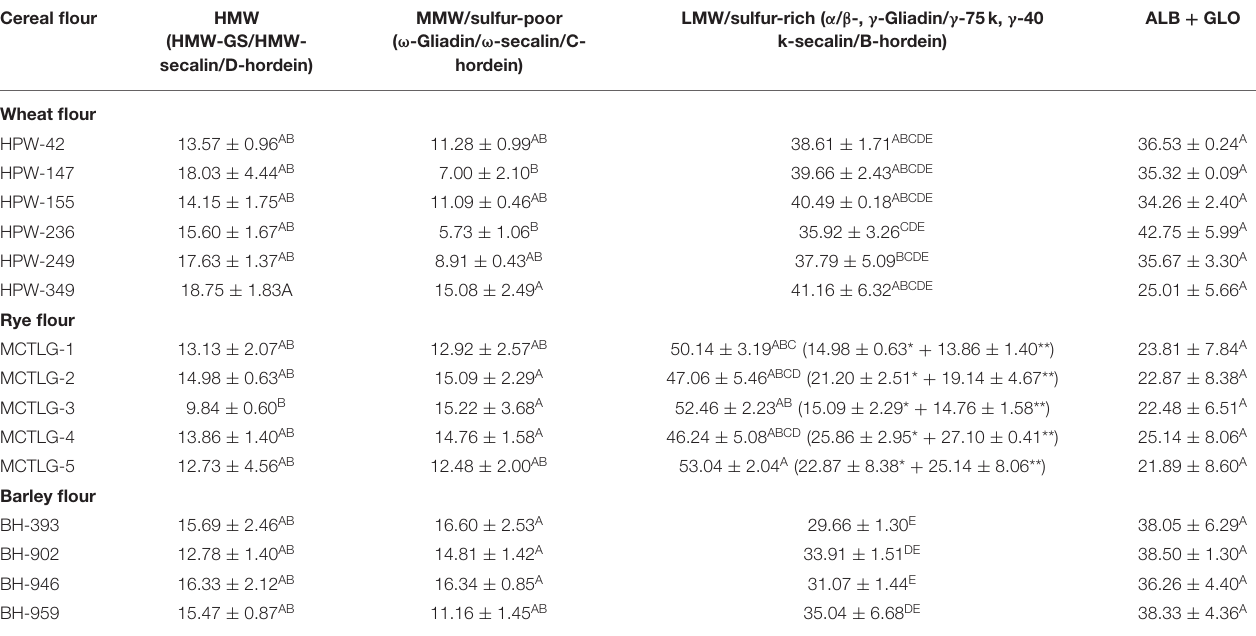
TABLE 6 | The relative proportion (%) of total flour proteins in wheat, rye, and barley cultivars. Cereal